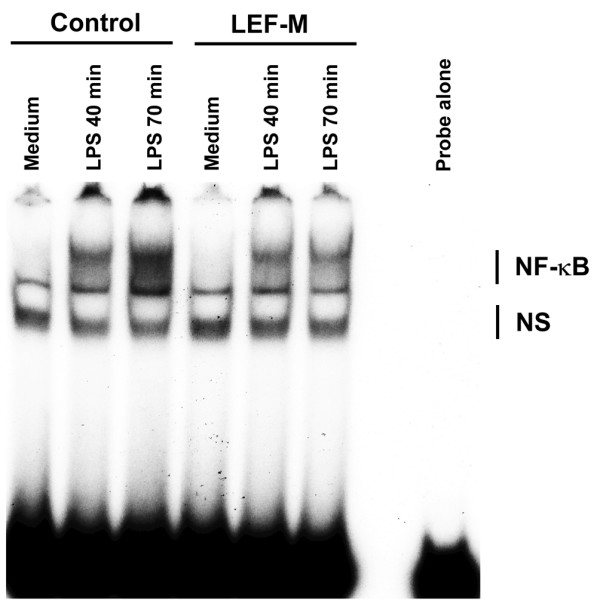
LEF-M suppresses LPS-induced NF-κB activation in DCs. Immature dendritic cells (DCs) were cultured for 2 hours with or without the active metabolite of leflunomide (LEF-M; 150 μmol/l), followed by addition of lipopolysaccharide (LPS; 100 ng/ml) or medium as control. After 40 and 70 min total nucleoprotein was extracted and nuclear factor-κB (NF-κB) activity was detected using electrophoretic mobility shoft assay. Similar results were obtained in two independent experiments. (Nonspecific bands are labelled NS.)